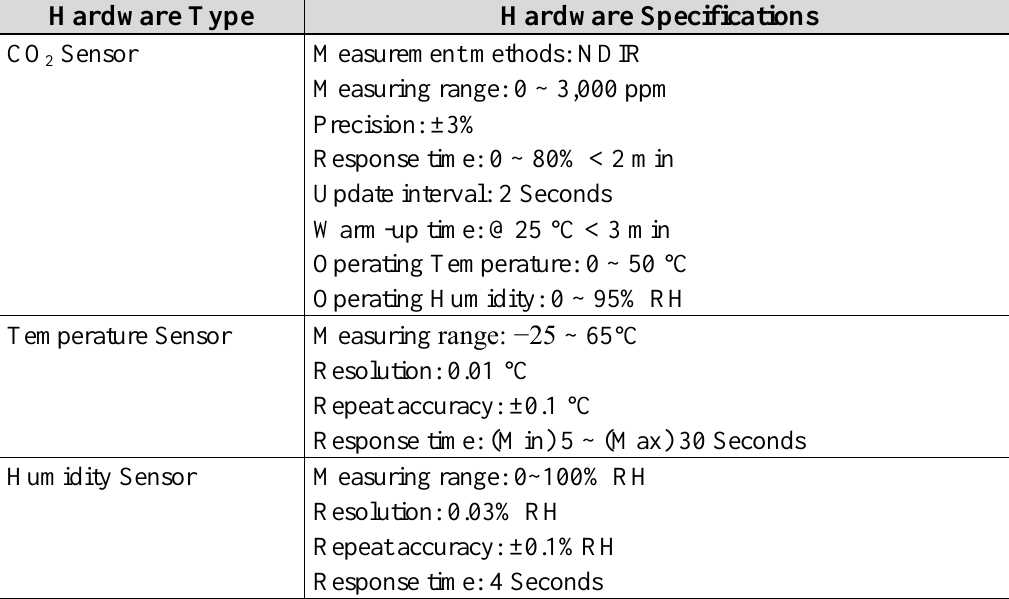
Table 2. Hardware type and specifications of Wired Integrated Sensor Nodes.